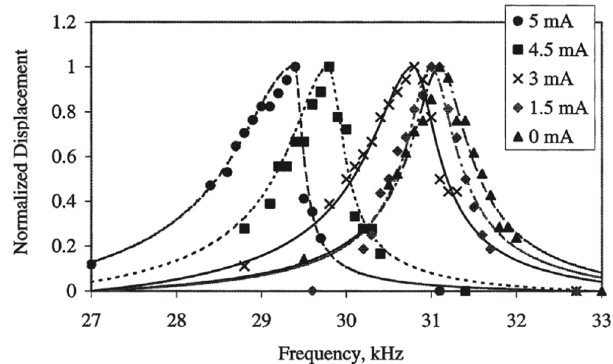
Figure 5. Simulation curve of local thermal stress effect correction proposed from UC Berkeley.